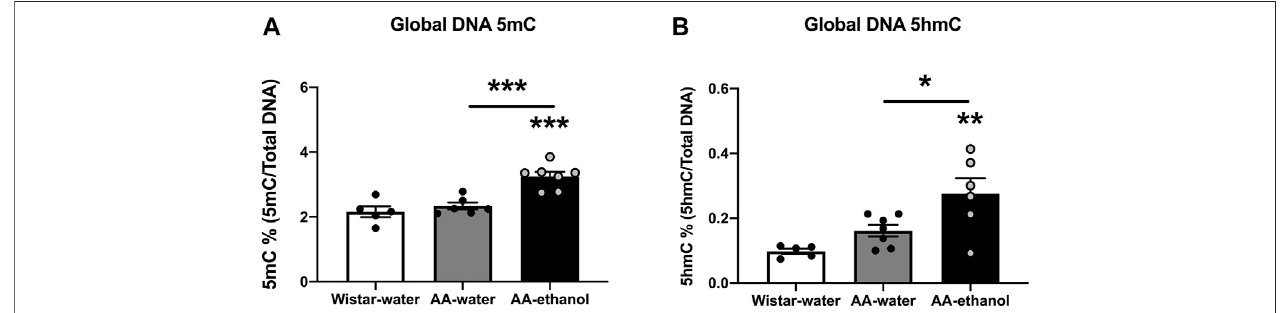
FIGURE 3 | Global DNA methylation (5mC%) (A) and hydroxymethylation (5hmC %) (B) levels in the NAc. One-way ANOVA followed by Tukey ’ s multiple comparisons test; *** p < 0.001, ** p < 0.01, * p < 0.05, compared with the Wistar-water group; n (cid:2) 5 – 7. Error bars indicate SEM.